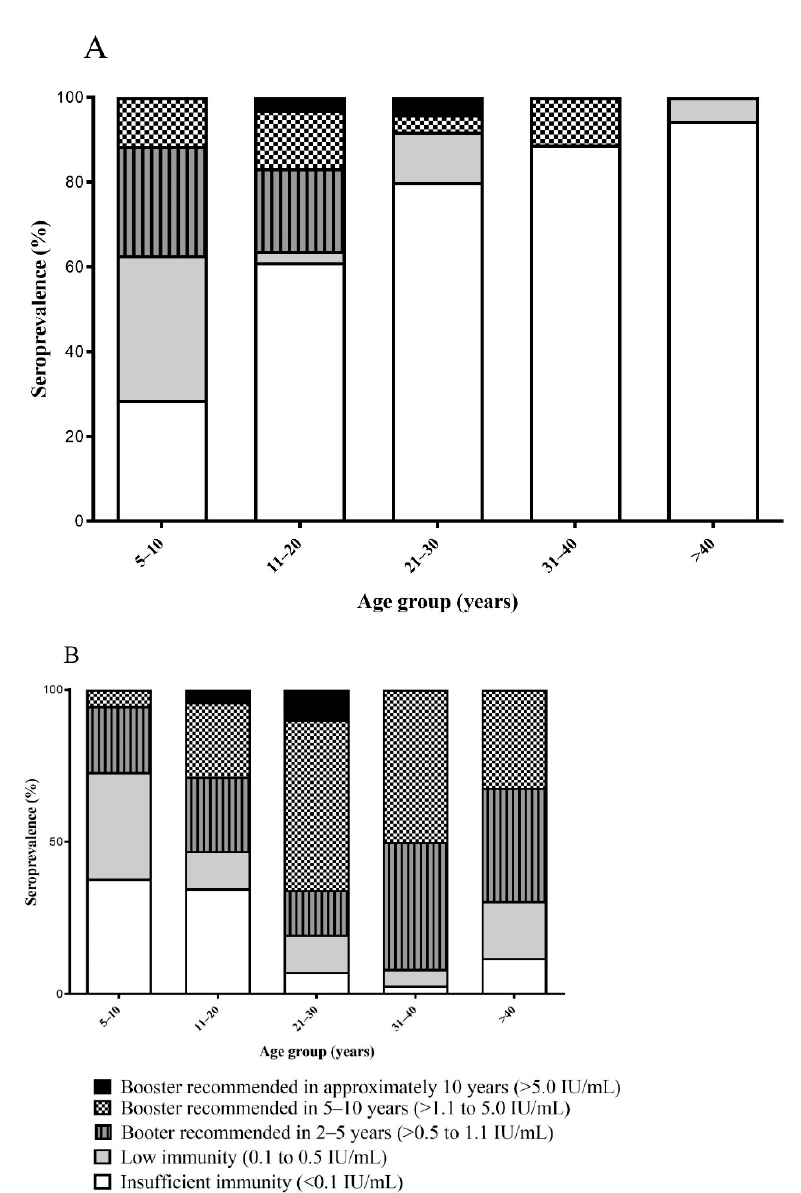
Figure 3. Age-stratified tetanus seroprevalence status according to sex. ( A ) Male; ( B ) female.